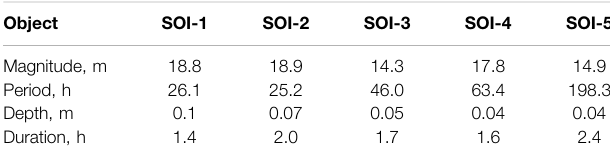
Frontiers in Astronomy and Space Sciences |